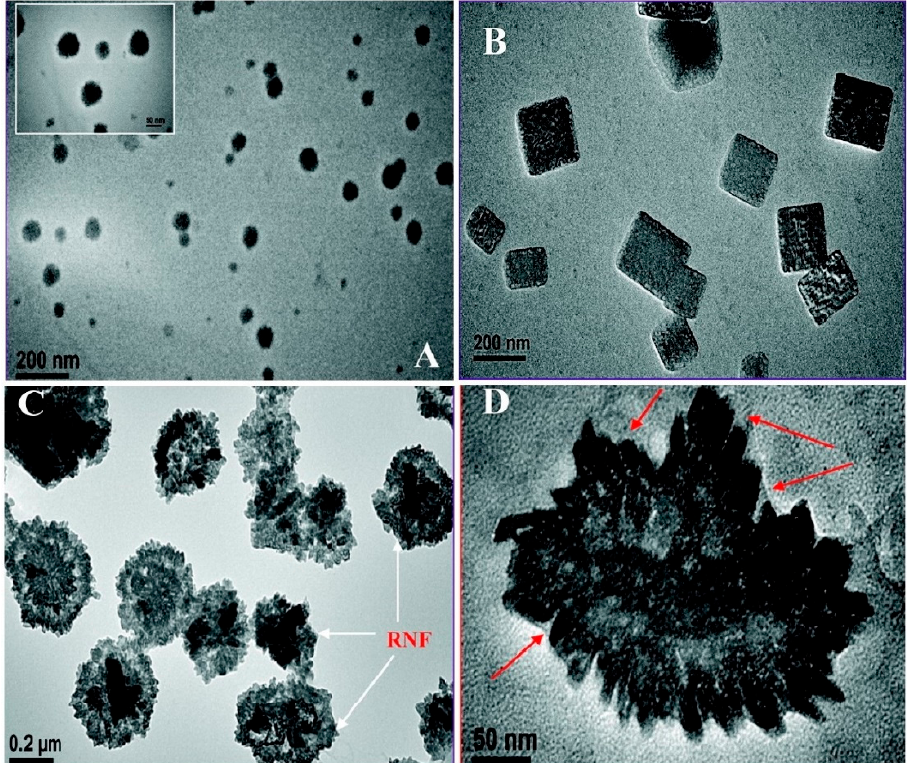
Figure 9. TEM images of ( A ) Rh nano spheres; ( B ) Rh nanocubes; ( C ) High-magnification image of Rh nanoflowers; ( D ) Image of a single Rh nanoflower, all synthesized by Kundu et al. [83], Reprinted with permission from [92] ( J. Phys. Chem. C 2009 , 113 , 18570–18577). Copyright (2009) American Chemical Society.